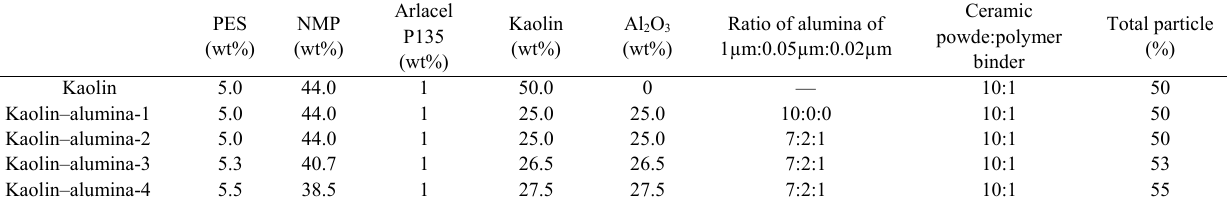
Table 1 Composition of the dope suspension for the preparation of kaolin/alumina hollow fibre